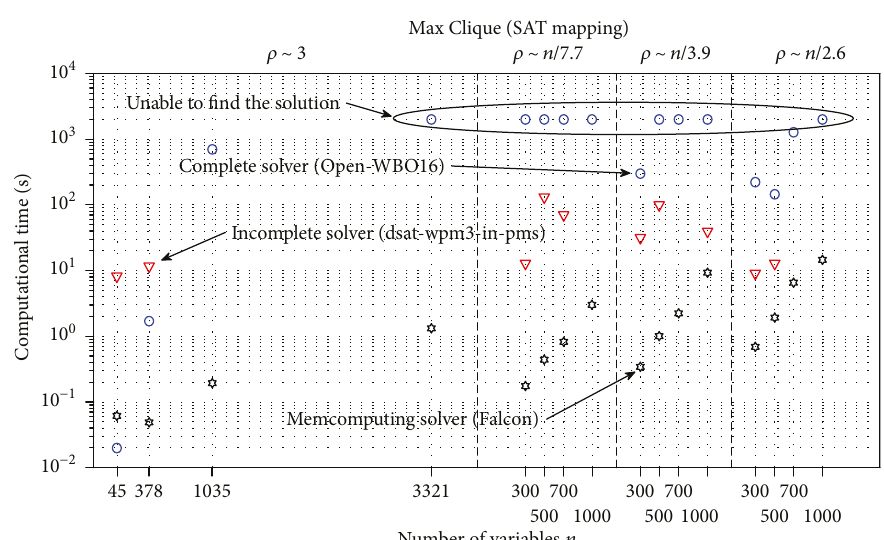
Figure 9: Results from the 2016 Max-SAT competition for the Max Clique problem compared with our memcomputing solver,